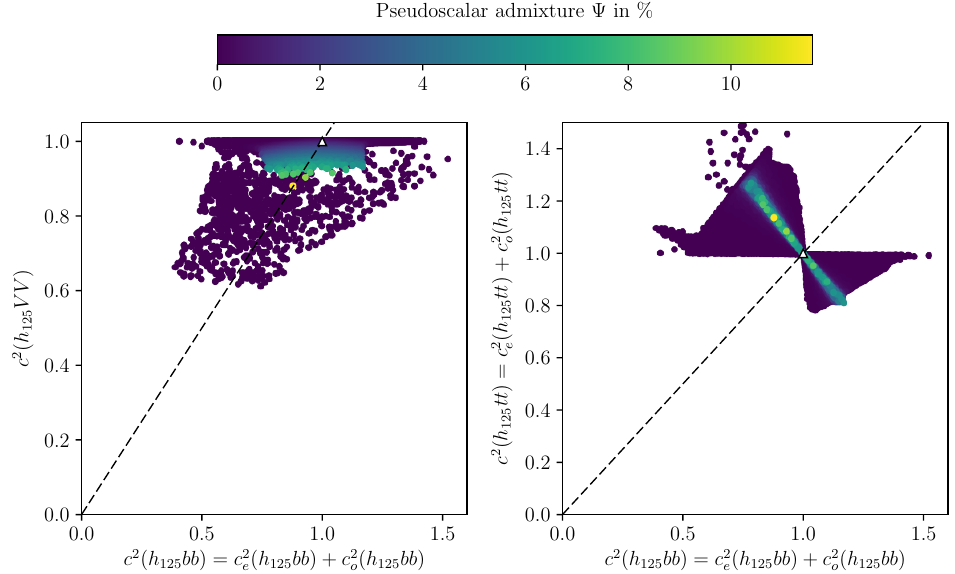
Figure 3 . C2HDM type II: pseudoscalar admixture (cid:9) C2HDM of h 125 as a function of the e(cid:11)ective couplings squared. The white triangle denotes the SM value. The dashed line represents equal scaling of the